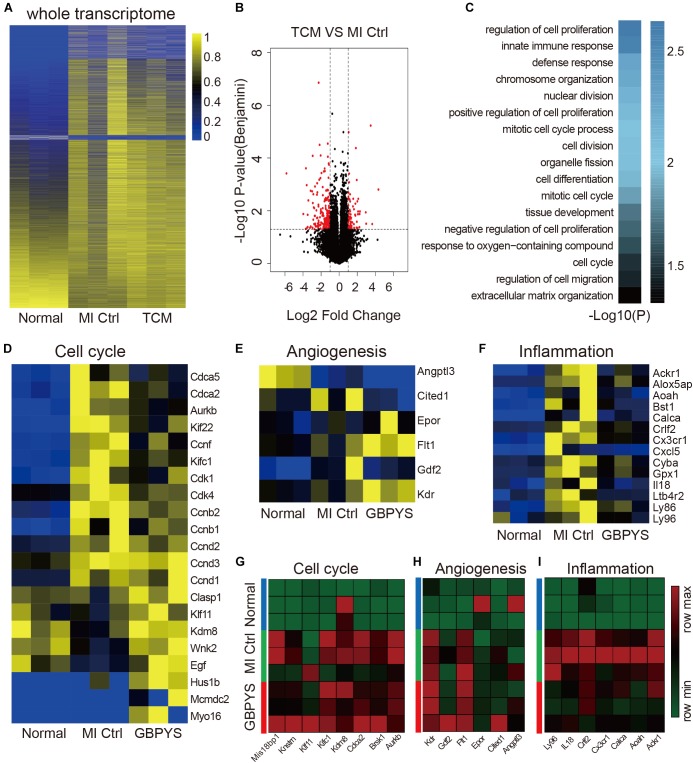
Whole-transcriptomic RNA sequencing showed that GBPYS feeding at day 7 after MI induced complex changes in expression level of cell cycle-, angiogenesis-, and inflammation-related genes. (A) Heat map of the whole transcriptomes of all samples indicated that global gene expression after GBPYS treatment is distinct from control feed at day 7 (n = 3 per group). (B) Volcano plot of the RNA-seq data of GBPYS feeding group versus Ctrl group with regular feeding at day 7 after MI (n = 3 per group). (C) Gene ontology (GO) analyses of genes with significant change in expression level in the GBPYS feeding group versus the Ctrl group at day 7 after MI (n = 3 per group). (D) Expression of genes involved in cell cycle at day 7. (E) Expression of genes involved in angiogenesis at day 7. (F) Expression of genes involved in inflammation at day 7. (G–I) Quantitative PCR validation of expression changes of several key genes in cell cycle, angiogenesis, and inflammation pathways from the RNA-seq data at day 7 after MI. P < 0.05, Student’s t-test.